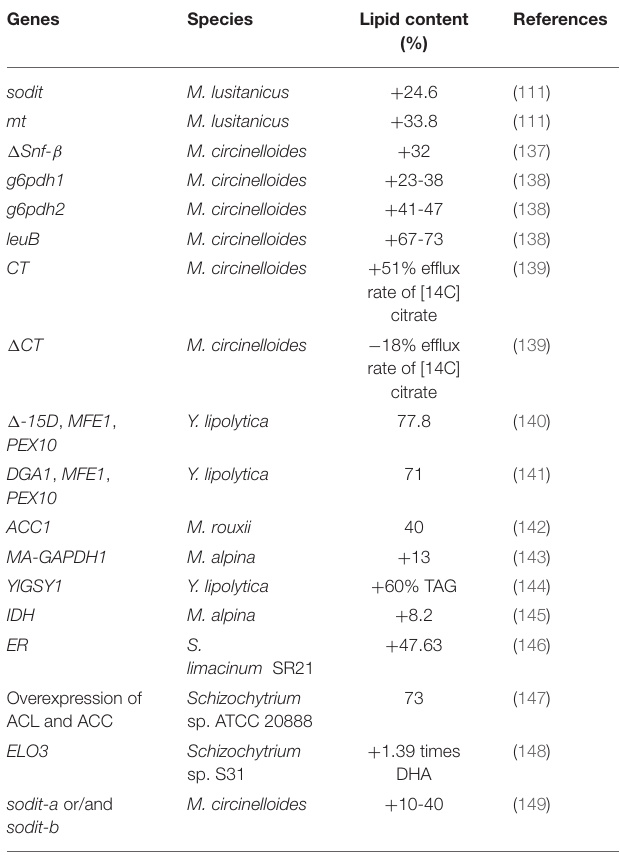
TABLE 3 | Researches about lipid synthesis by overexpressing genes or knocking-out